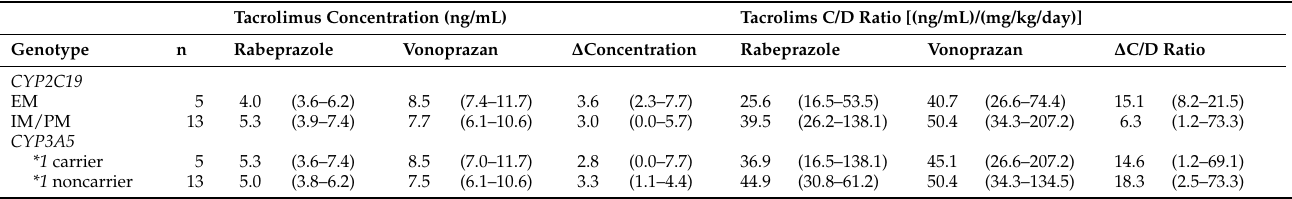
Table 2. Comparison of tacrolimus trough concentration and the C/D ratio among the various CYP genotypes. Tacrolimus Concentration